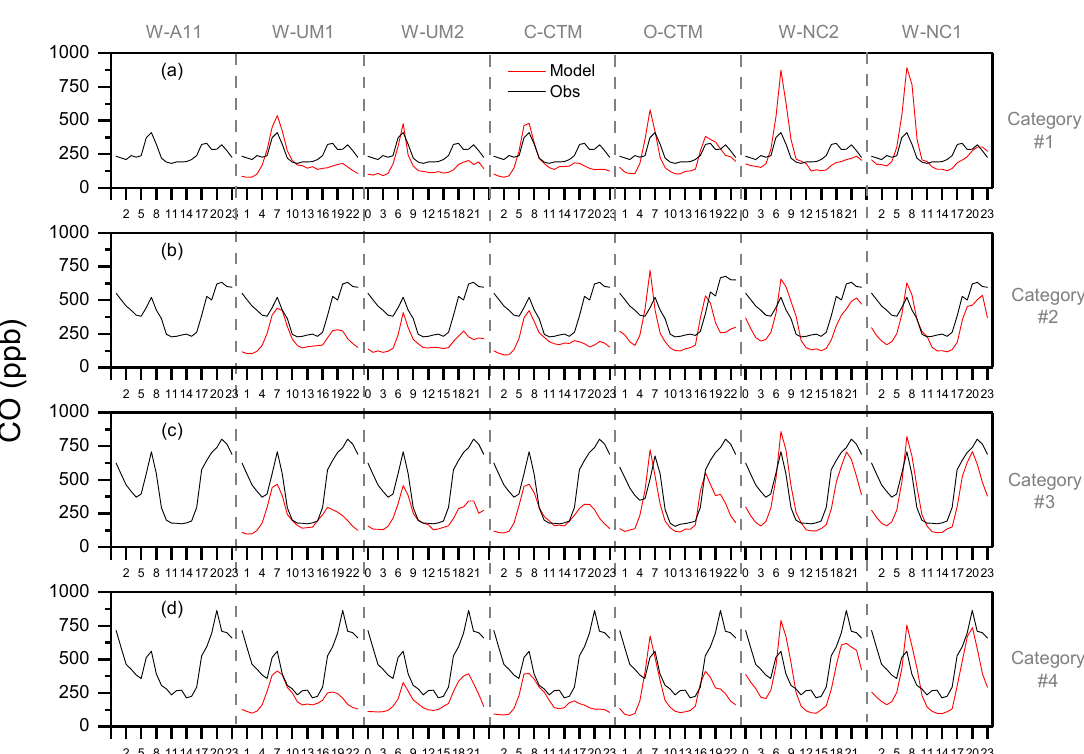
Figure 14. Diurnal composite observed (5 m) and modelled (z 1 average) CO at Westmead. Panels a—d represent each of the four radon-based mixing categories (Table 1).